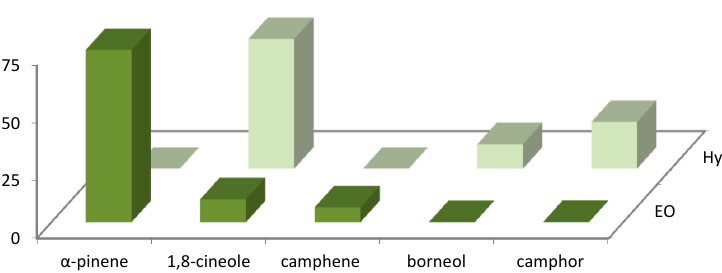
The distribution of the main volatile compounds detected in R. officinalis and L. offici-